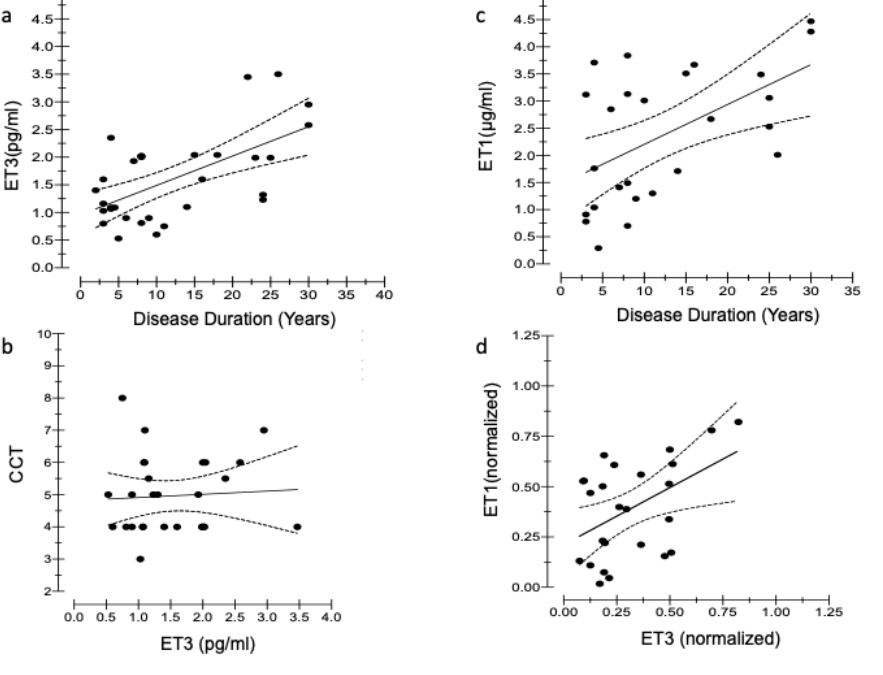
Figure 2: Analysis of correlation among the variables cerebral circulation time (CCT), endothelin-1 (ET1), endothelin-3 (ET3), and disease duration in MS patients. (a) Correlation between ET3 and disease duration. ET3 changes during the disease duration reached significant statistical difference using the Pearson correlation coefficient (two-tailed) ***p = 0,0002. (b) Correlation between ET3 and CCT. The CCT delay was not statistically significantly correlated to increased ET3 titration. (c) Correlation between ET1 and disease duration. ET1 was statistically significantly correlated with disease duration using the Pearson correlation coefficient (two-tailed) r = 0.54025 with a 95% confidence interval between 0.19336 - 0.76708, R2 = 0.29187, **p = 0.0044 (alpha = 0.05). (d) Correlation between circulating ET3 and ET1. Increasing ET3 and ET1 plasmatic titration levels were statistically significantly correlated using Pearson correlation coefficient. (r=0,54025 with 95% confidence interval 0.19336 to 0.76708 and R squared=0,29187). The increasing ET3 plasmatic values are statistically correlated with increasing ET1 plasmatic values and the P (two-tailed) value results as 0,0044